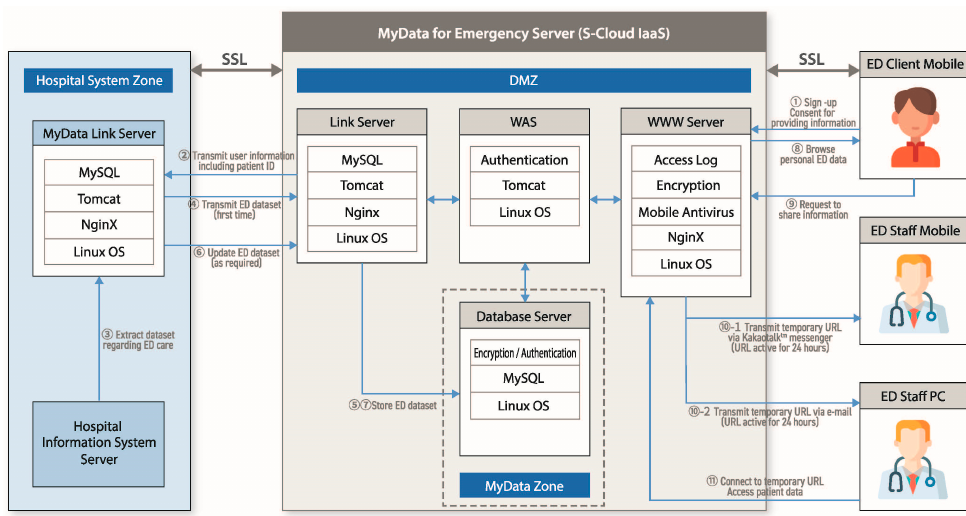
Figure 3. System and server architecture for FirstER. Data transmission and reception between the hospitals and the MyData cloud servers were linked by RESTful API, SSL, and JSON. A patient sends his or her hospital ID to the HIS through the private cloud platform when the patient agrees to subscribe to the mobile app and the collection / use of their personal information. After validation of the subscriber information, the ED core data of the patient are extracted from the HIS server to the MyData-linked server in the hospital. Afterwards, when a patient requests “download”, the core data of the patient are transferred from the connected server in the hospital to the MyData cloud platform (OS: operating system, ED: emergency department, SSL: Secure Socket Layer, ID: identification, IaaS: